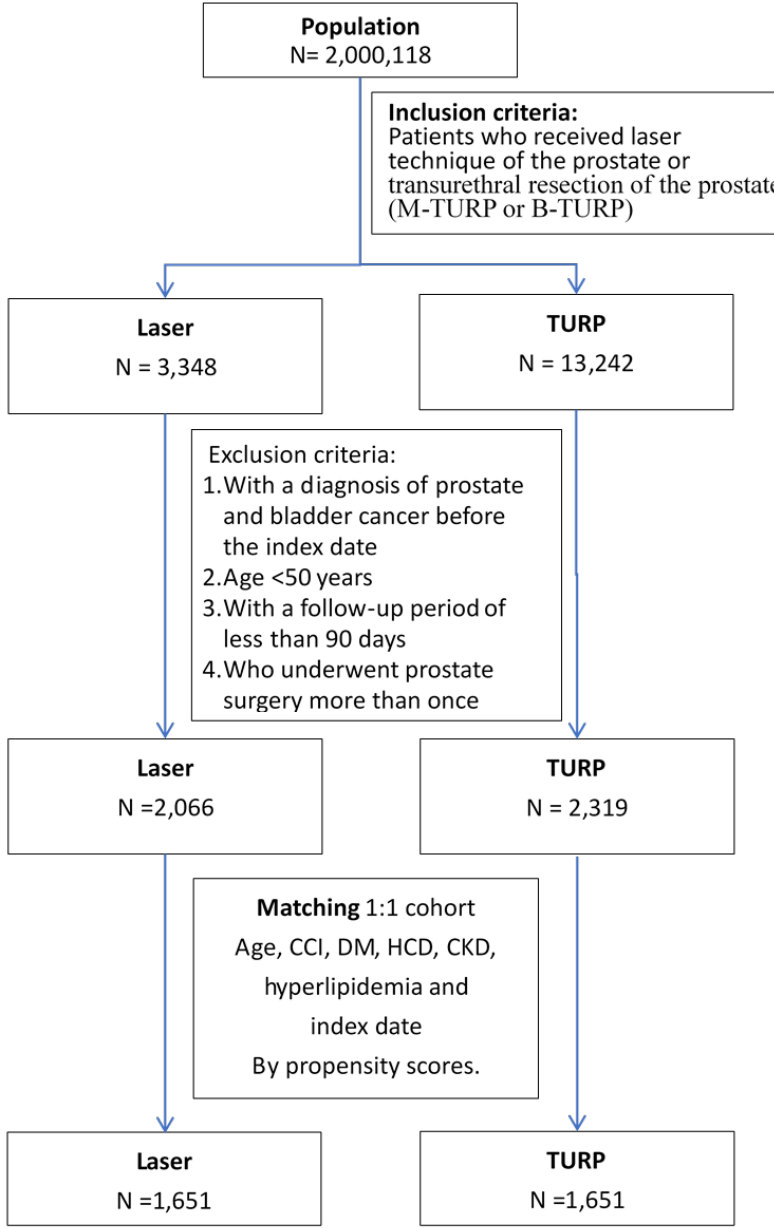
Figure 1. Flowchart of patient selection. Abbreviations: TURP: transurethral resection of the prostate; M-TURP: monopolar transurethral resection of the prostate; B-TURP: bipolar transurethral resection of the prostate; CCI: Charlson comorbidity index; HCD: hypertensive cardiovascular disease; DM: diabetes mellitus; CKD: chronic kidney disease.